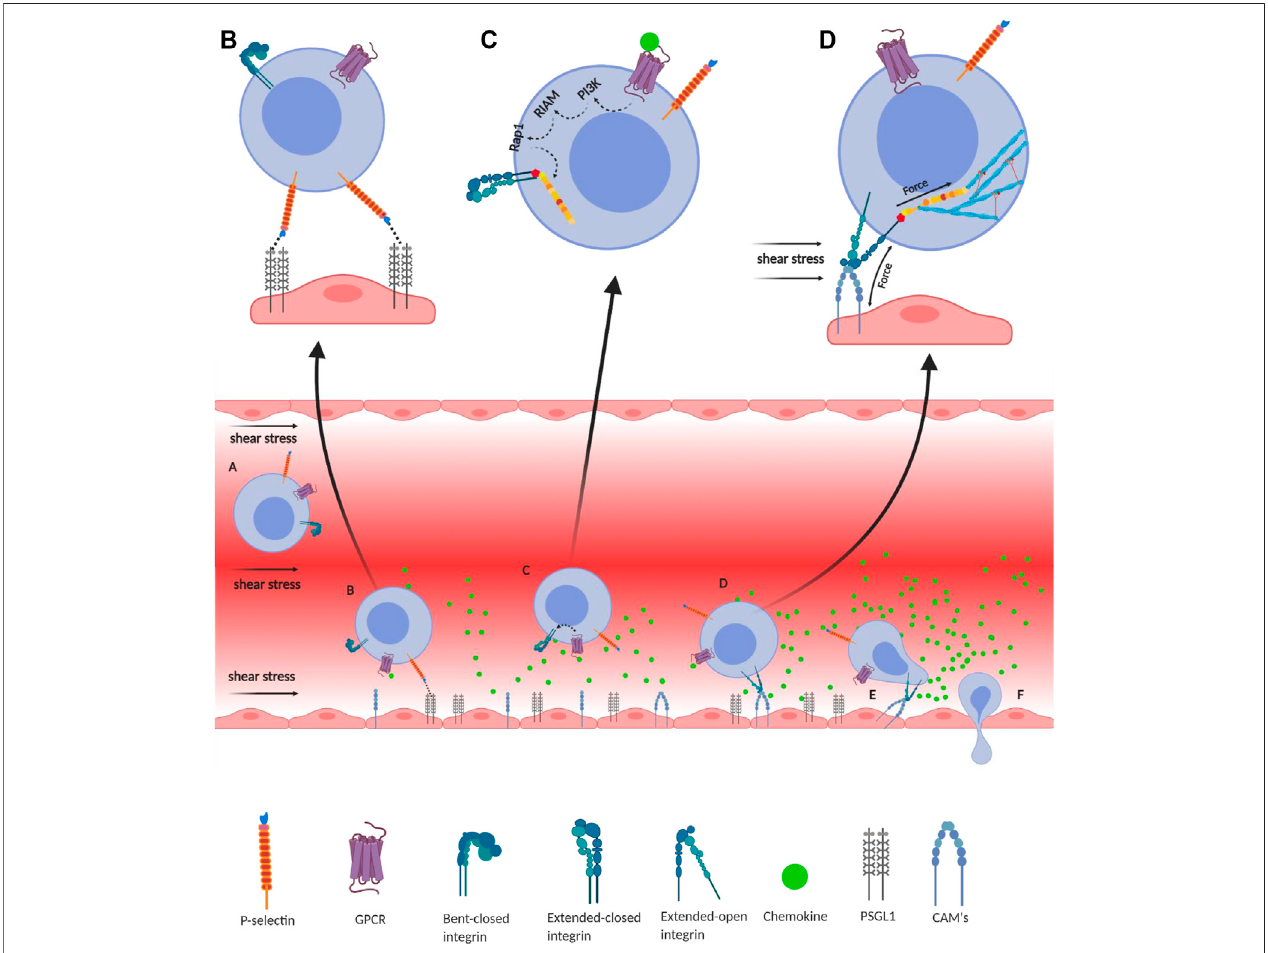
FIGURE2| Integrin-mediatedimmunecelladhesiontoendothelialcellsunderashearforceofblood fl ow. (A) Migrationofimmunecellsunderforce — immunecells traveling through the blood vessel experience a shear force of the blood fl ow. Chemokines (green) are secreted by the endothelial cells lining the tissue displaying self- antigens; however, the chemokine gradientishighest near theinfectious tissue. The chemokines slow down the fl ow rate ofthe migratory leukocytes towards thesite of infection under the shear stress of blood fl ow, equivalent to 1 dyn/cm 2 . (B) Slip-bond formation and decrement in cell migration velocity — cells gradually decrease the speed alongwith therise ofchemokinegradient and tumble on the endothelial cellsof theblood vessel. Theselectinmolecules, expressed by theleukocyte, interact with its counterpart expressed on the endothelial cells. However, their interaction under a shear force ofblood fl ow causes the slippage ofthe bonds, allowing the cell to rollontheendotheliallayer,whilerollingnumerousnumbersofslipbondformsandbreaksbetweenthemoleculeslikeP-selectin,E-selectin,PSGL1,E-cadherin,etc. (C) Extended-closed integrins — theGPCR expressed ontheleukocytesinteractswiththechemokine toactivate PI3Kthatinduces Rap1 – RIAMcomplextoactivatetalin for furtherbinding withthe β subunitcytosolictail ofintegrin. This partially activates integrin fromits bent-closedto extended-closed structure. (D) Integrinactivation leading tofocaladhesion — theextended-closedintegringetsactivated,eitherbyoutside-insignalingbyinteractingwithCAMwhilerollingontheendotheliallayerorbyinside-out signaling through sensing the force from talin – actin complex. The activation breaks the integrin salt bridge, transforming it into a thermodynamically unstable but active extended-openconformation.Thisformsintegrin – ligandcatchbondsunderblood- fl owshearforce,resultingincompleteadhesionoftheimmunecellstotheendothelial layer. During this interaction, the force is transmitted through integrin both outside and inside the cell, which fi nally transduces downstream forming the focal adhesion. (E) Adhesion of cell — this focal adhesion regulates the cell ’ s shape and migration and strictly adheres the cell on the endothelial layer by inducing the catch-bond formation. (F) Diapedesis — while remaining attached on the endothelial surface in the infected tissue, the self-reactive immune cells transmigrate in between adjacent cells by diapedesis towards the infected tissue region (Zhu et al., 2007b; Jahed et al., 2014; Huse, 2017).